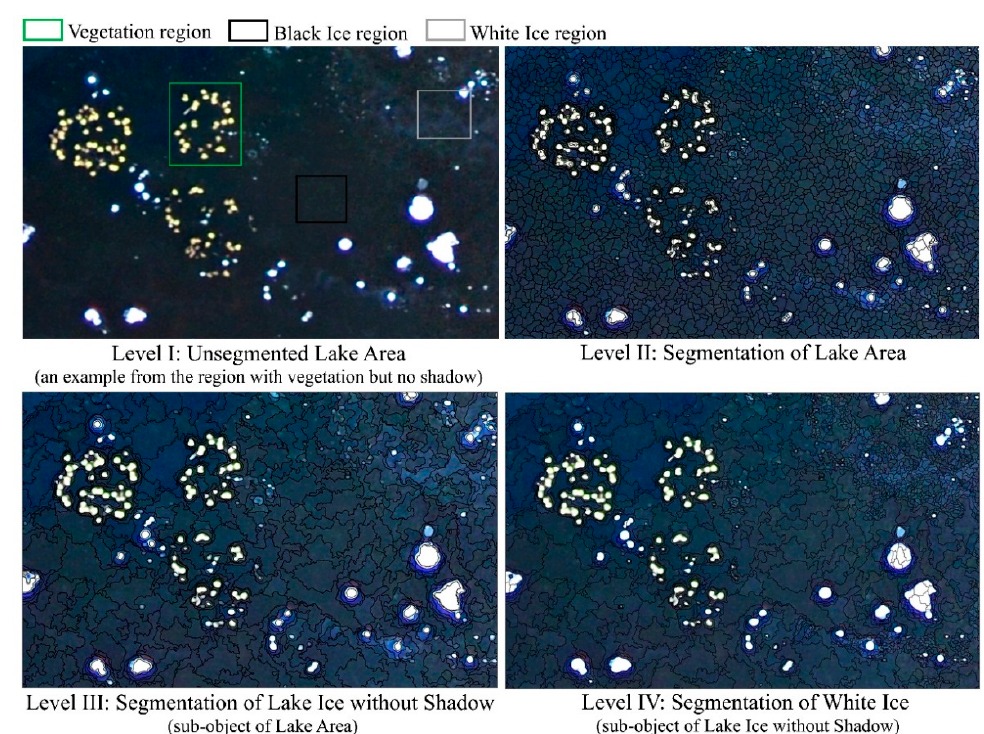
Figure 4. Multiresolution segmentation results show transition of target image objects in terms of shape and size from one level to another. The entire lake area comprised of vegetation, dark, and white ice is segmented (scale factor = 15) in Level II to separate these sub regions. In Level III, only the region with lake ice without shadow comprised of dark and white ice is segmented (scale factor = 50) and only white ice is segmented (scale factor = 10) in Level IV.